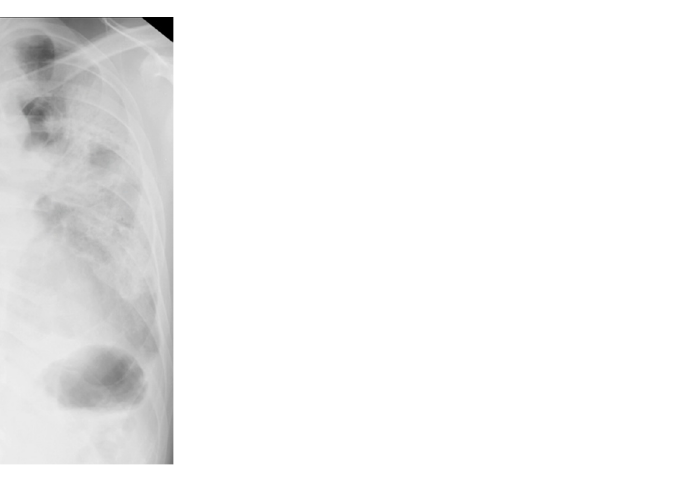
Figure 3. Chest X-ray of a 59-year-old man with dyspnea. It showed consolidation throughout his left lung field.